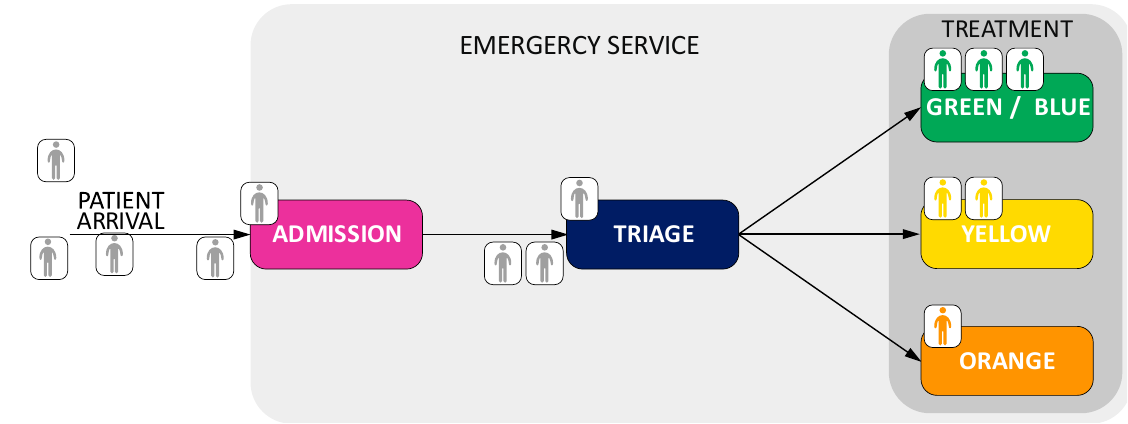
Figure 2. Illustrative scheme of emergency process stages for an episode.